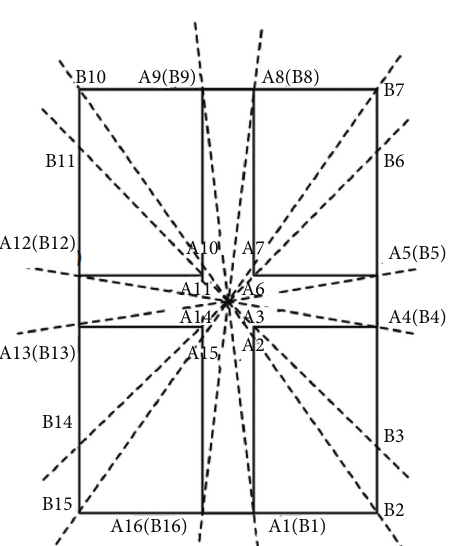
Figure 5: Shape blended graphics with different t